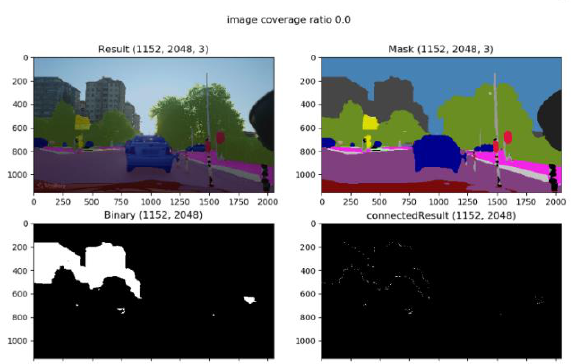
Figure 11. An image (image key: 32pUYPVcaPCp0TMWdg_SVA) with building coverage ratio 0.49